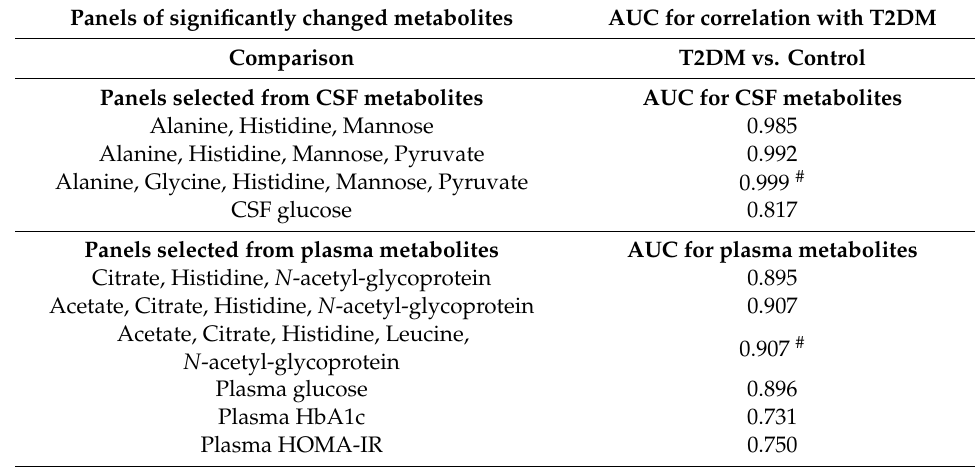
Table 4. Estimated AUC value of multi-marker panels for correlation with the presence of T2DM. Panels of significantly changed